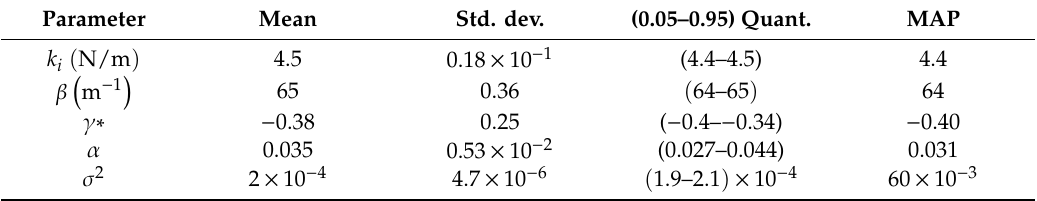
Table 3. Marginal posterior distribution of the BWBN benchmark model